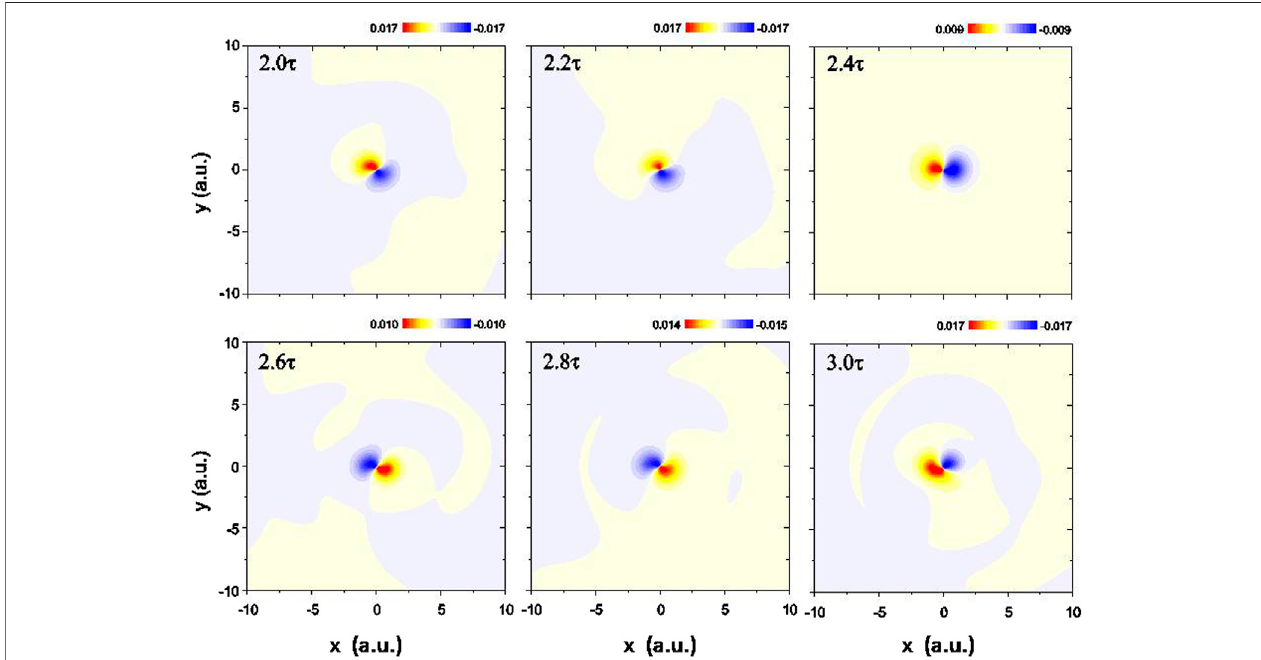
FIGURE5| Timedependenceoftheinducedangularprobabilityelectroncurrent j (cid:3) θ ( x , y , z (cid:1) 0 , t ) atdifferentmoments t (unitof τ (cid:1) τ 1 (cid:1) 2 π / ω 1 )forthemolecularaxis parallel to the laser polarization ( x , y ) plane, that is, in-plane R (cid:3) E , by bichromatic counter-rotating ( ϵ (cid:1) − 1) circularly polarized laser pulses at wavelengths λ 1 (cid:1) 70 nm ( ω 1 (cid:1) 0 . 65 au)and λ 2 (cid:1) 35 nm( ω 2 (cid:1) 1 . 3 au),intensities I (cid:1) 1 × 10 14 W/cm 2 (E (cid:1) 0.0534 au),duration T lp (cid:1) 5 τ 1 (cid:1) 10 τ 2 (580 asFWHM),andCEP ϕ (cid:1) 0.Unitsofinduced angular electron probability currents are arbitrary.